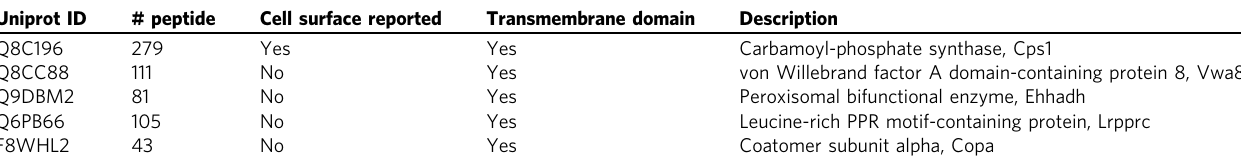
Table 2 Mass spectroscopy analysis of a gel band (red arrow in Fig. 7b) identi fi ed fi ve hepatocyte putative membrane